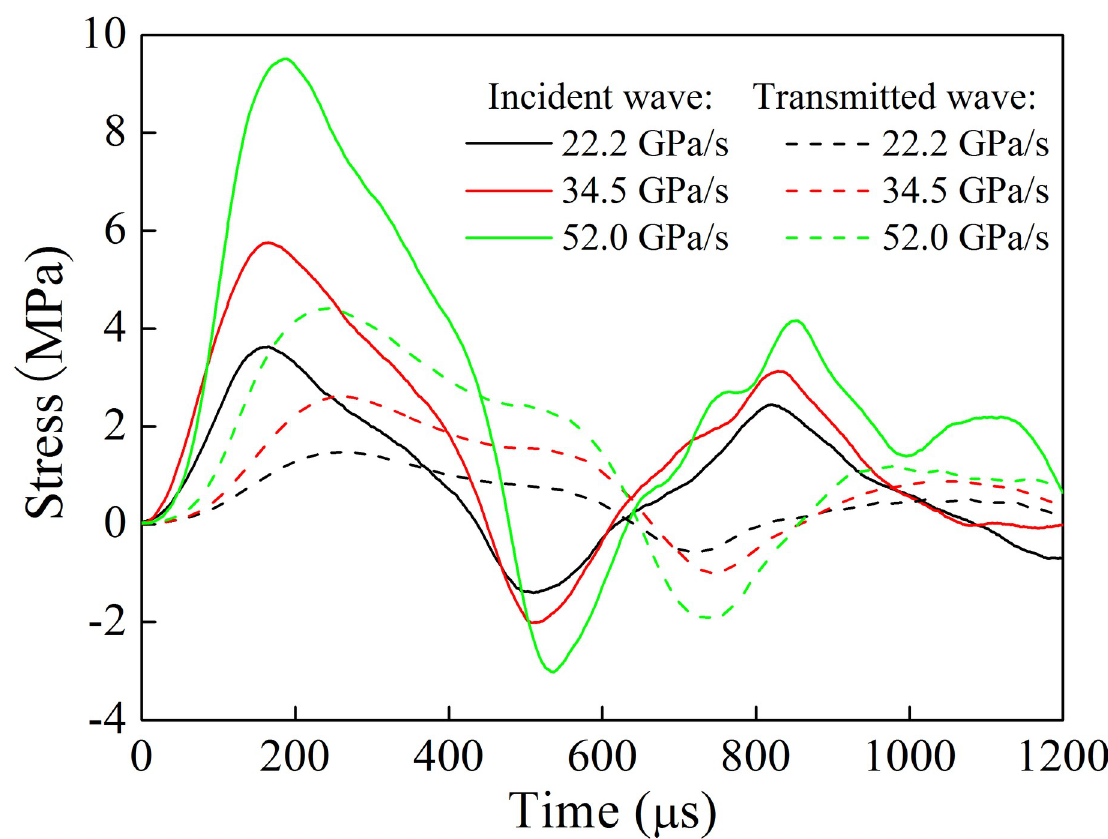
Fig 11. Stress time history curve in the bar with a single